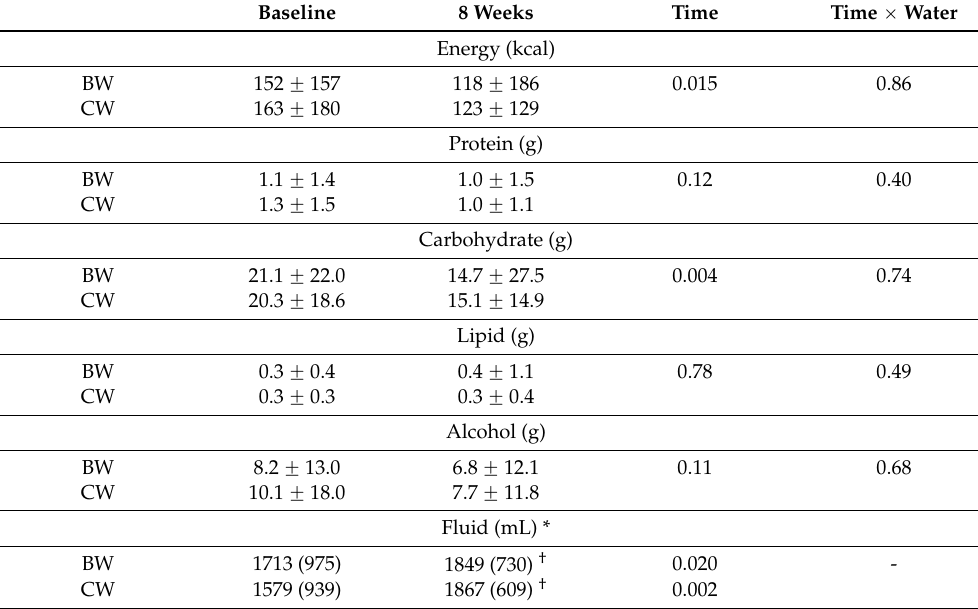
Table 3. Energy, macronutrients, alcohol, and fluid intake provided by beverages of volunteers consuming bicarbonated water (BW) or control water (CW) for 8 weeks.